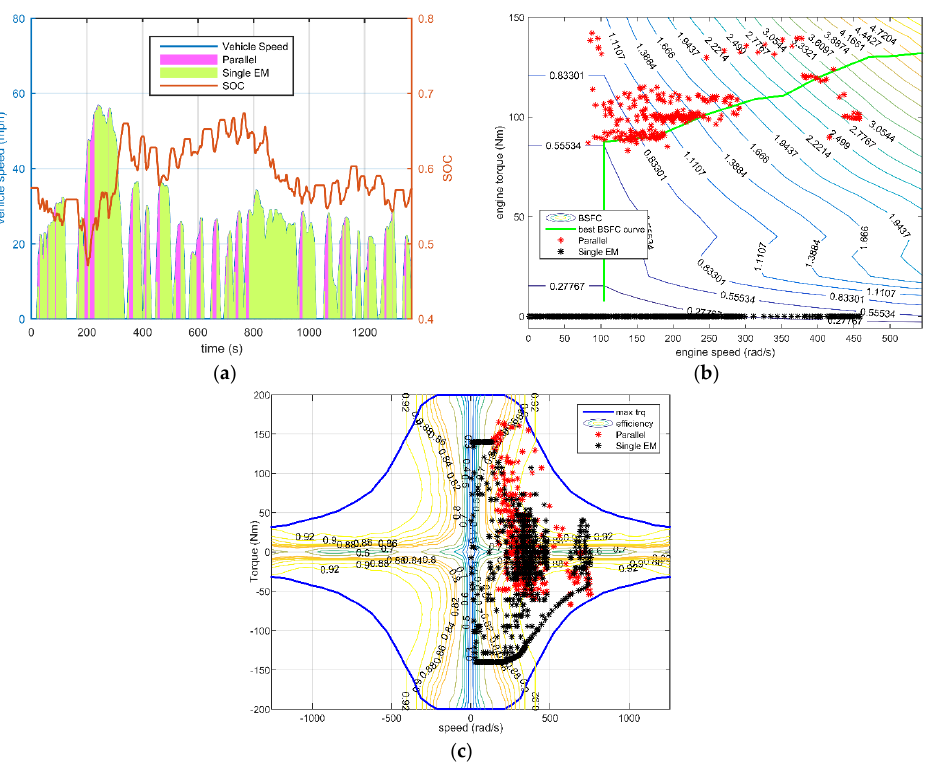
Figure 16. ( a ) Battery SoC trajectory and mode selection over the UDDS drive cycle; ( b ) engine optimal operation points over the UDDS drive cycle; ( c ) EMB operating points over the UDDS drive cycle.